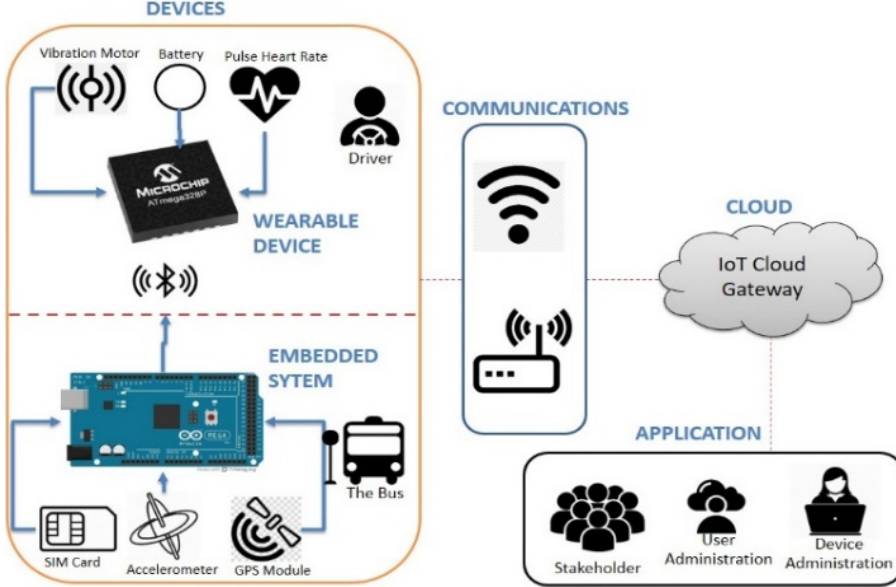
Figure 3. Smart driver architecture.